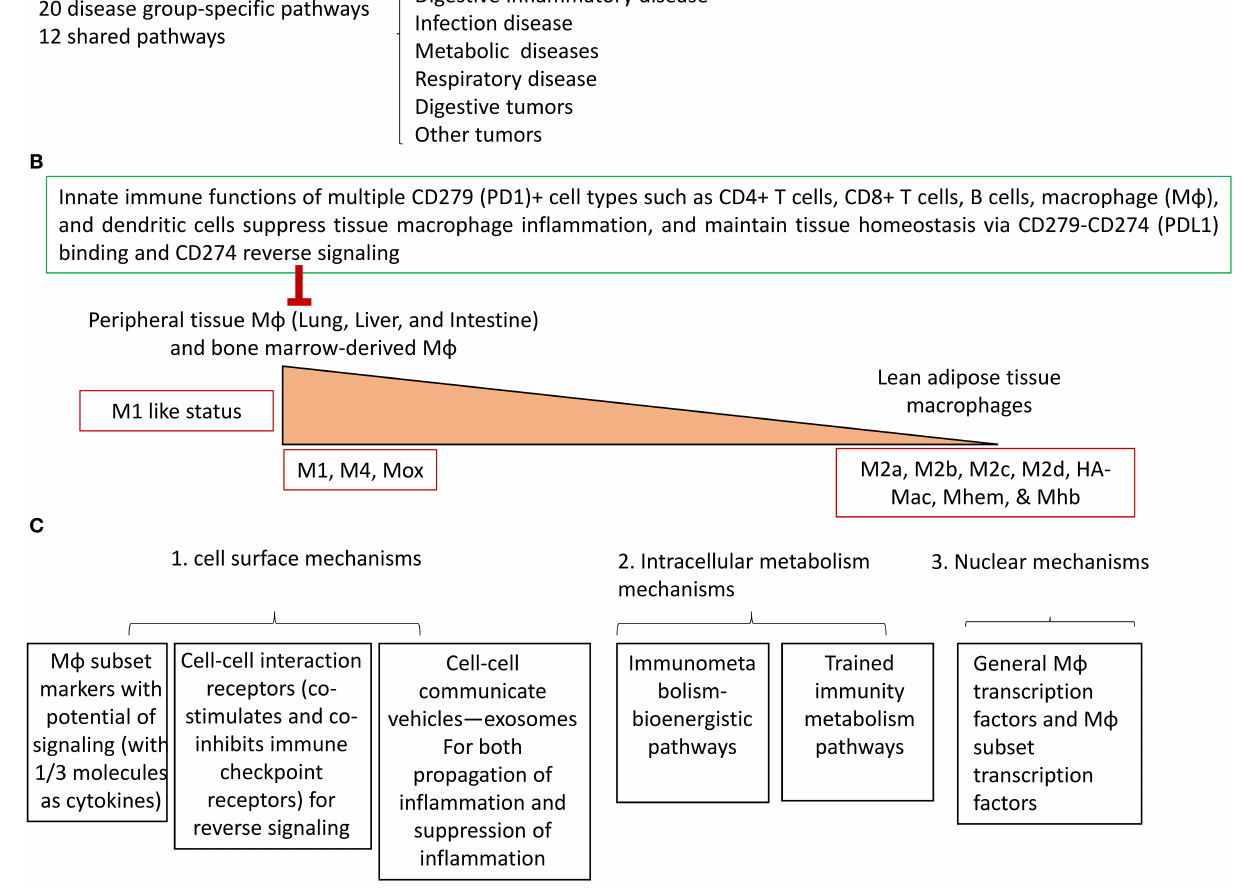
FIGURE 7 | A new working model. (A) Twenty novel disease group-specific-, and 12 new shared- macrophage pathways have been identified in eight groups of 34 diseases including 24 inflammatory organ diseases and 10 types of tumors as the phenotypic findings. (B) To identify potential mechanisms underlying the macrophage phenotypes, we identified new tissue mechanisms that macrophages in peripheral tissues have higher M1 like pro-inflammatory status than lead adipose tissue macrophages, which are controlled by high expression of the immune checkpoint/co-inhibition receptor CD274 via its reverse signaling. (C) We identified six new cell and molecular mechanisms including three cell surface mechanisms, two groups of intracellular metabolism pathways and two groups of nuclear transcription factors.